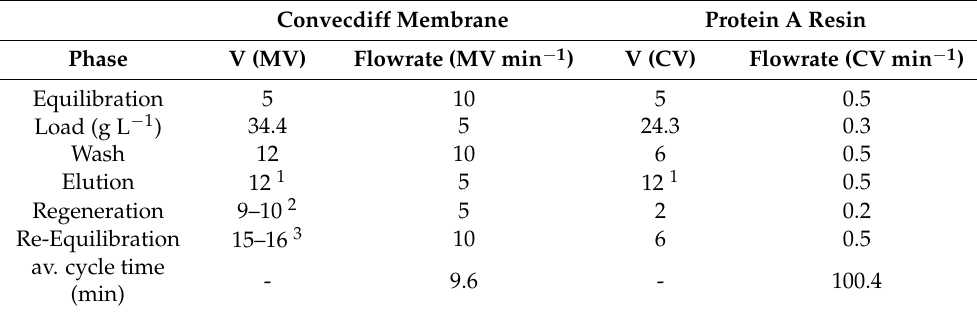
Table 3. Chromatography recipes for one cycle of mAb capture with convecdiff membrane ver- sus